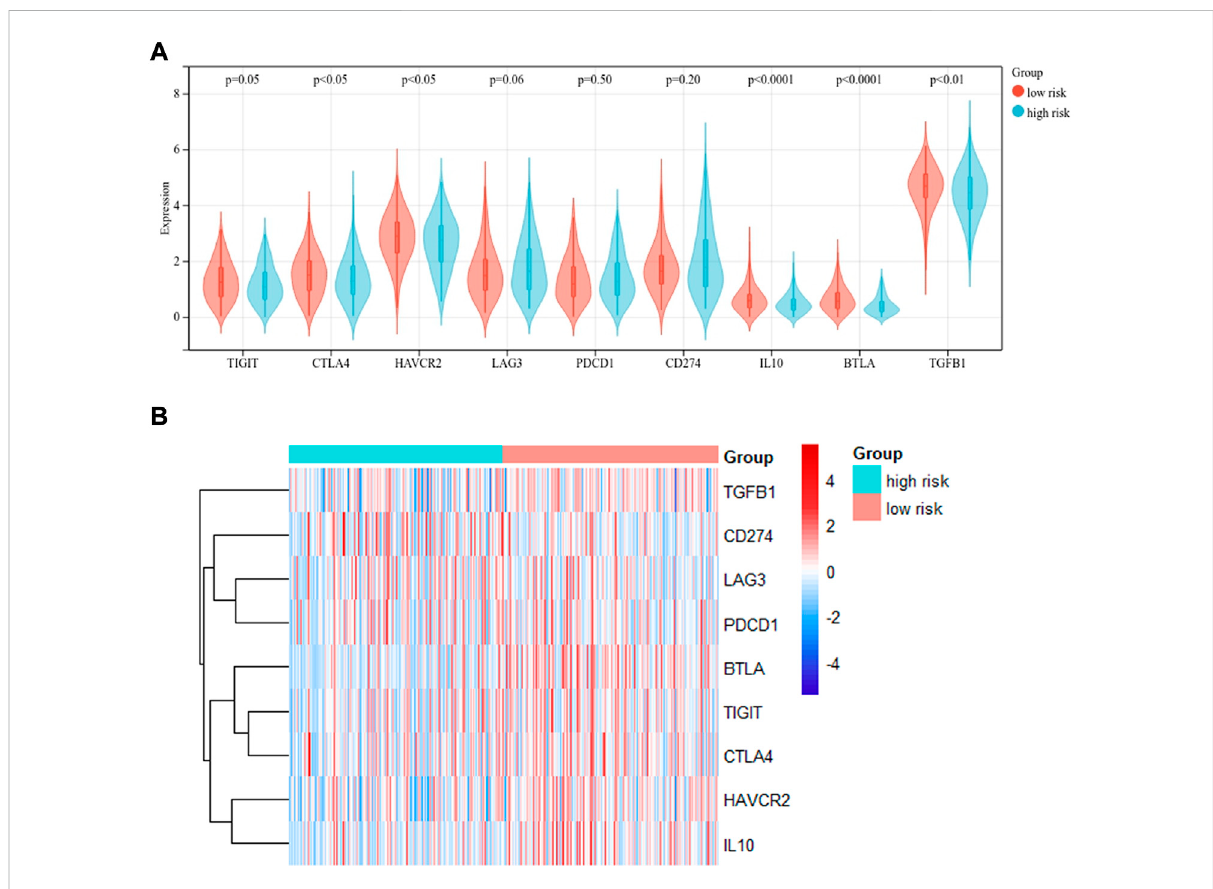
FIGURE 8 Correlation between risk group and immune checkpoints. (A) The difference of immune checkpoint expression between the two groups divided by risk score level. (B) Heatmap showed the expression of immune checkpoints in two